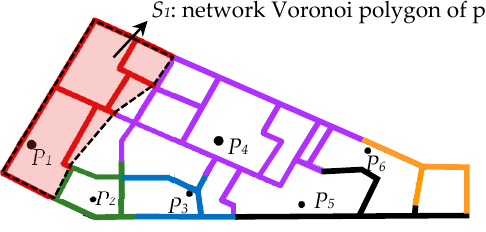
Figure 9. Network Voronoi polygon .